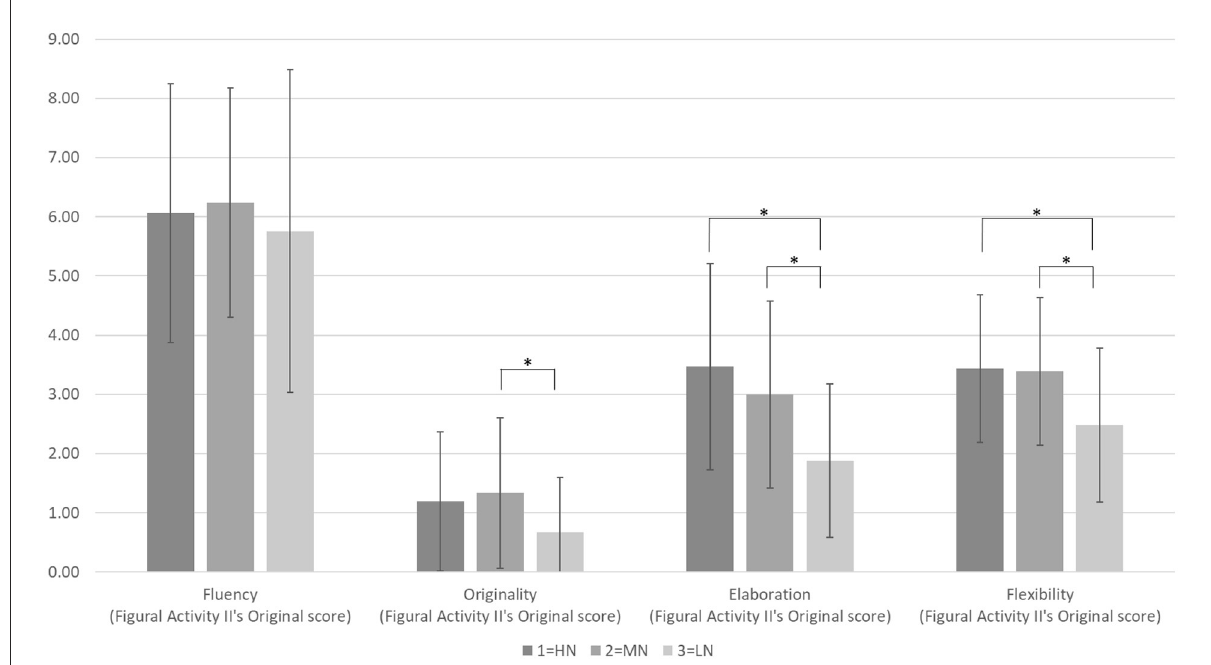
FIGURE4 The effect of different degrees of perceived naturalness on creativity performance in Figural Activity 2. N = 98, HN (n = 32), MN (n = 33), LN (n = 33), * p < 0.05. This figure shows the creativities indicators of their means scores in different degrees of perceived naturalness. The error bars indicate the standard deviation. Nineteen samples scored zero on “originality” in the low naturalness